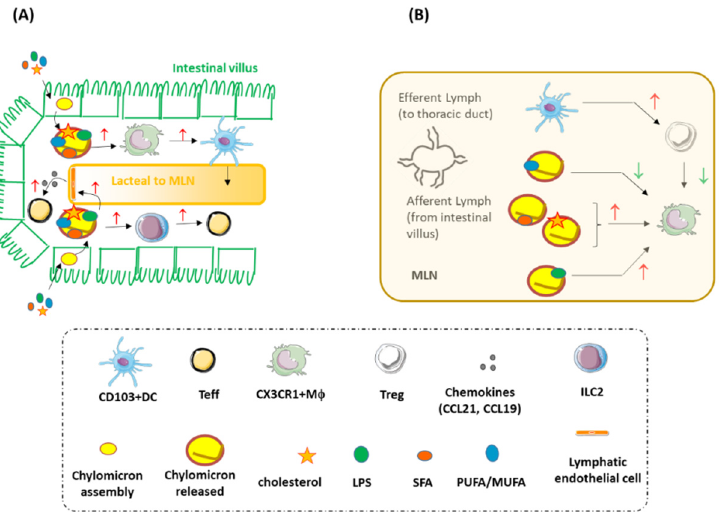
Figure 3. Summary of the immune-inflammatory pathways targeted by dietary fats in the intestinal villus ( A ) and in the MLN ( B ). LPS = lipopolysaccharide; CX3CR1 = C-X3-C motif chemokine receptor 1; M φ = macrophages; Teff = effector T cells; Treg = regulatory T cells; CCL- = C-C motif ligand-; ILC2 = innate lymphoid cell sub-type 2; SFA = saturated fatty acids; MUFA = mono-unsaturated fatty acids; PUFA = poly-unsaturated fatty acids; ↑ : indicates an activated cell or pathway; ↓ : indicates an inhibited cell or